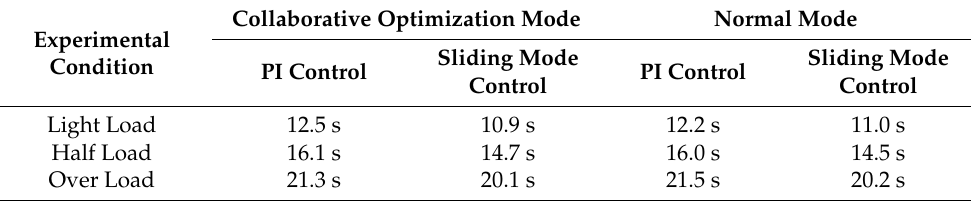
Table 5. Acceleration performance of electric vehicles under different control strategies.